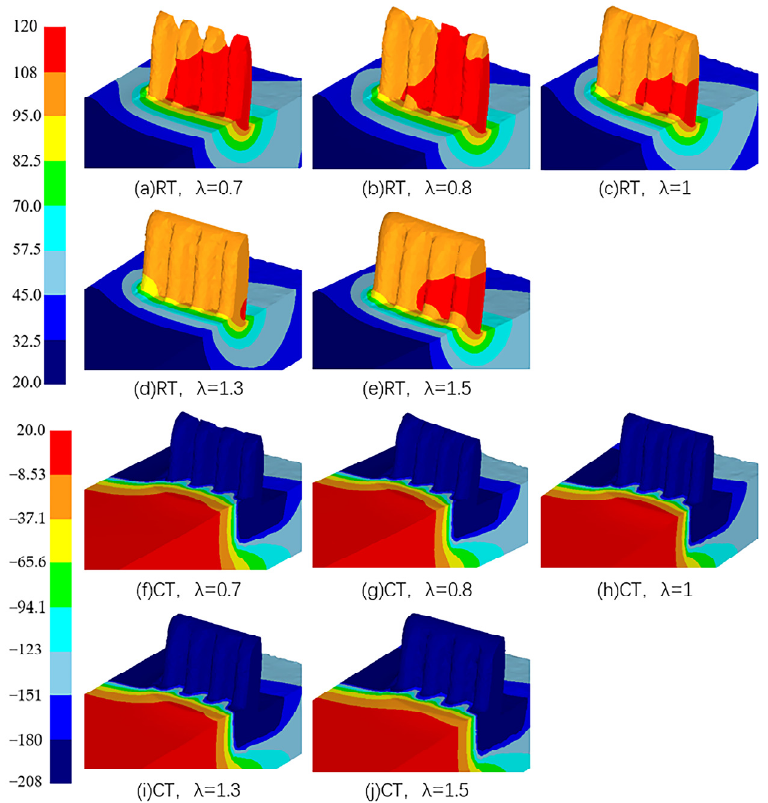
Figure 6. Temperature distribution of the fins under different conditions.